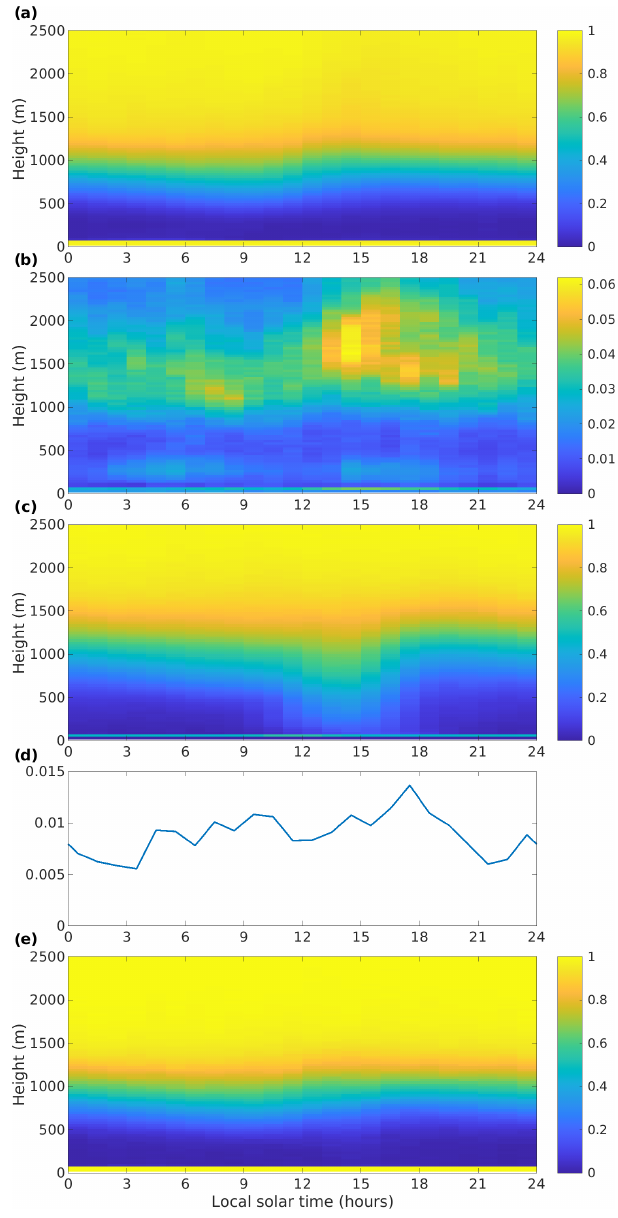
Figure 2. Fraction of Doppler lidar winds filtered at Granada by (a) the SNR filter, (b) the column-wise threshold filter, (c) the resid- ual filter, (d) the rain filter, and (e) all filters combined. Note the change in colour scale for (b) , since this filter is applied after the SNR filter. The rain filter is applied to the whole column. For panels (a) – (d) , the fraction filtered refers to the winds at nominal temporal resolution (10–15min) and for (e) to the 1h averaged